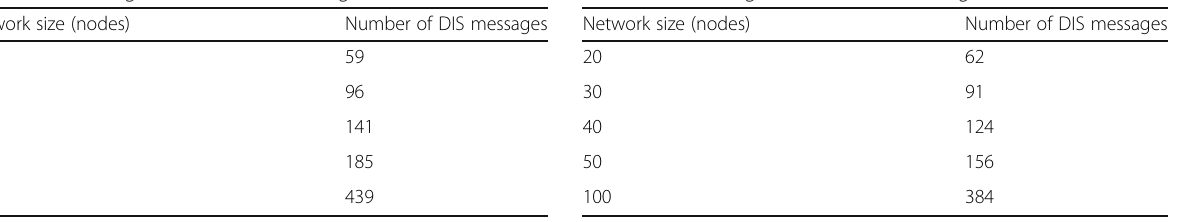
Table 7 Illustrating number of DIS messages for scenario II